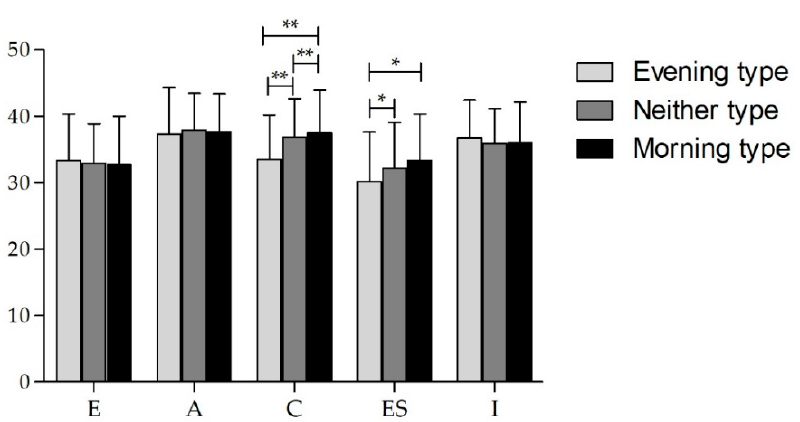
Figure 2. Personality dimensions of IPIP Big-Five (mean ± SD) and rMEQ interaction. E–extraversion; A–agreeableness; C–conscientiousness; ES-emotional stability; I–Intellect; * p < 0.005; ** p < 0.001. n = 712.